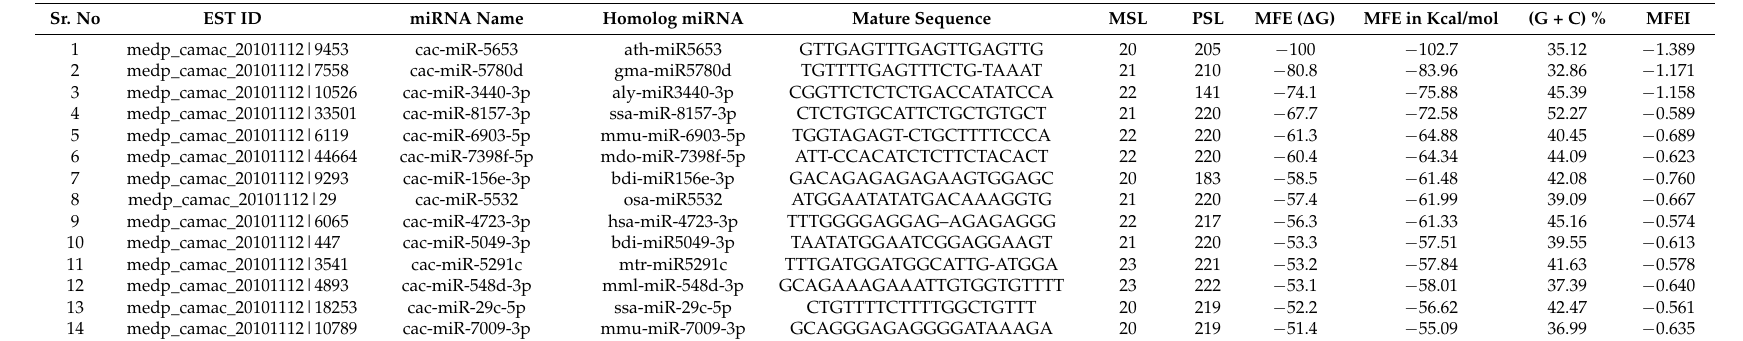
Table 1. List of 14 putative miRNAs identified in C.